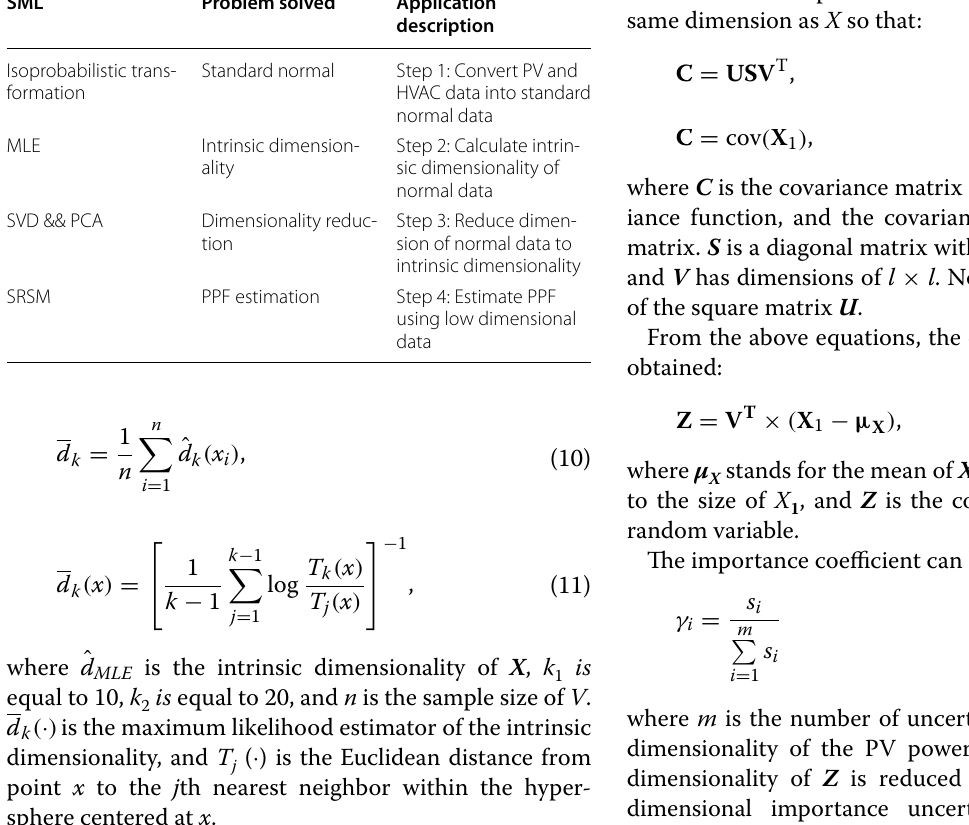
Table 3 Probability distributions for PPF estimation SML Problem solved Application Isoprobabilistic trans-